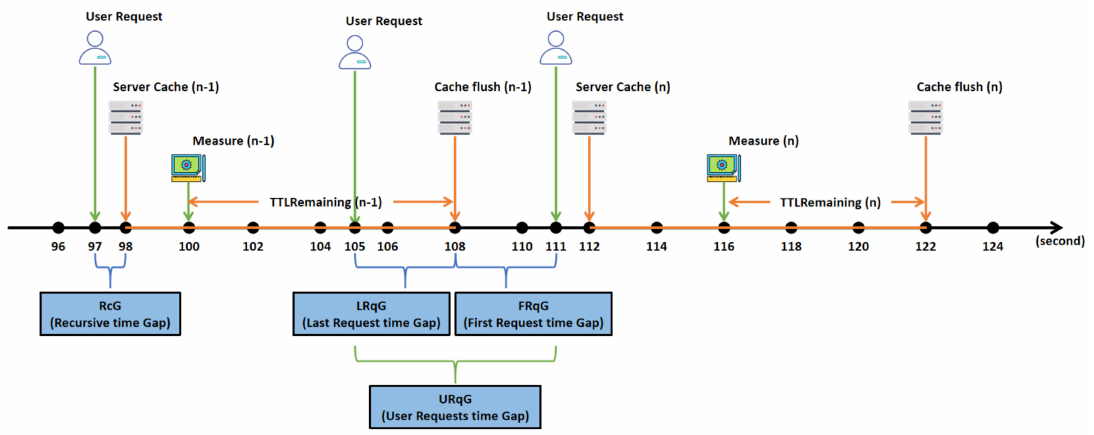
Figure 4. Measurement running